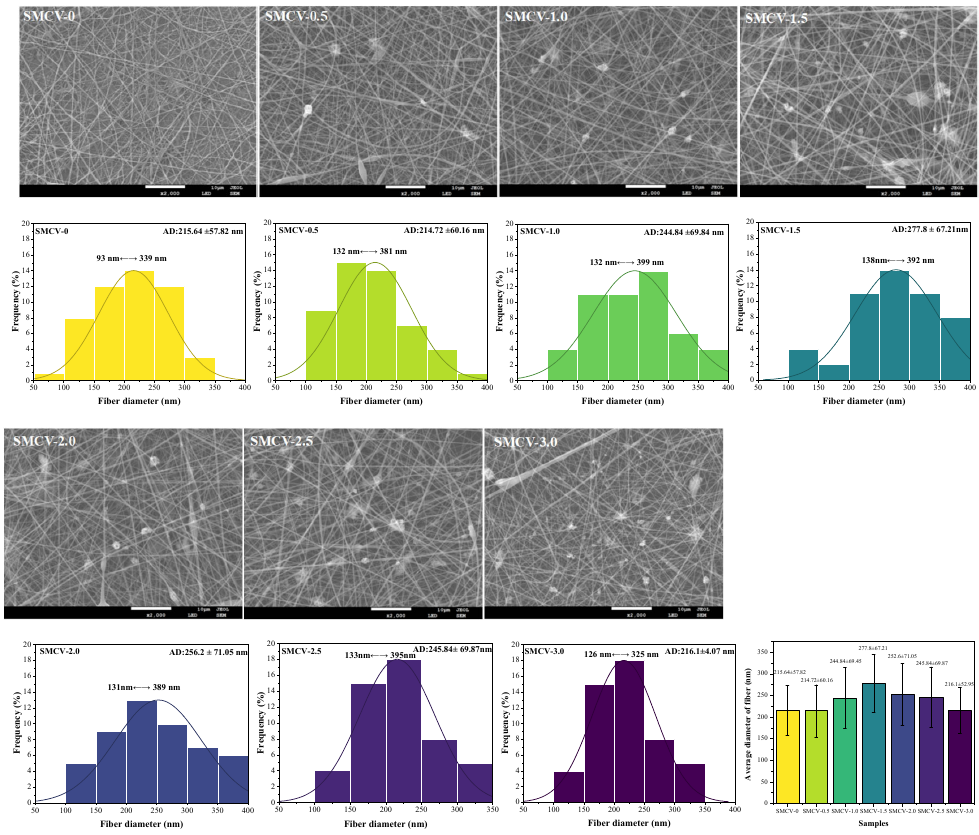
Figure 1. The SEM images, diameter distribution, and average diameters of SMCV (SMCV ‐ 0, SMCV ‐ 0.5, SMCV ‐ 1.0, SMCV ‐ 1.5, SMCV ‐ 2.0, SMCV ‐ 2.5, and SMCV ‐ 3.0).